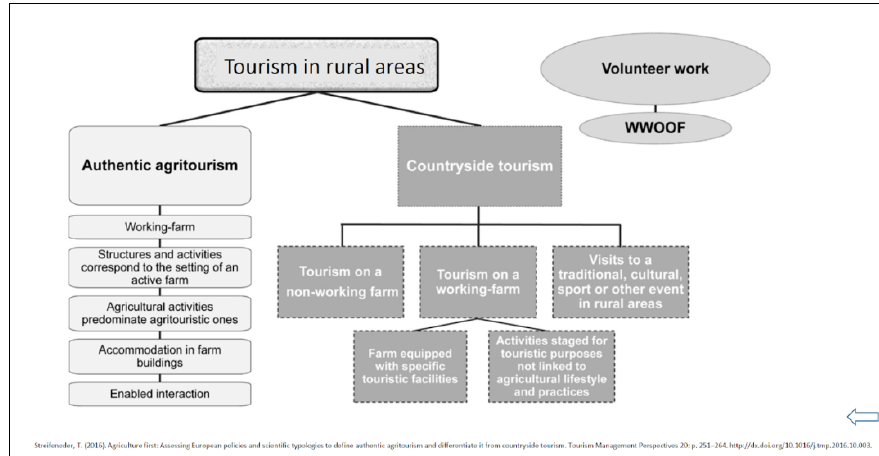
Figure 3. Distinctive Features of Authentic Agritourism and Countryside Tourism